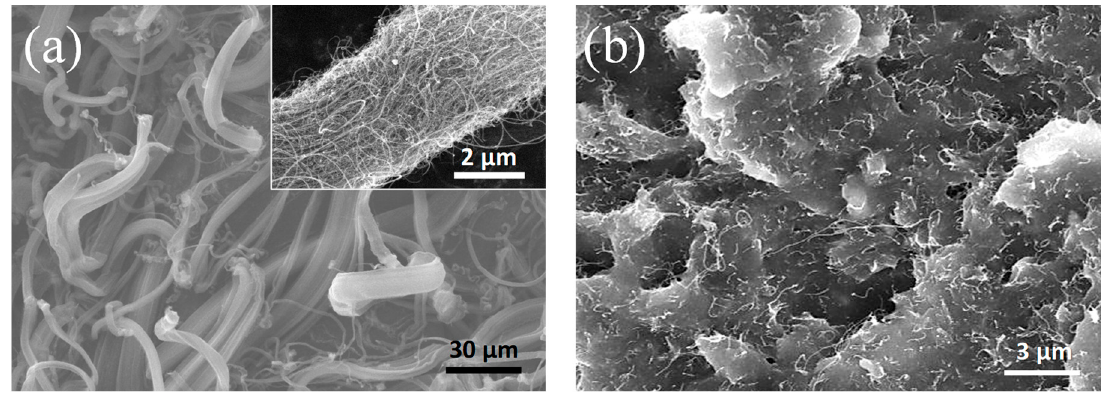
Figure 3. SEM micrographs of ( a ) as-received MWNTs, and ( b ) MWNT/polydimethylsiloxane (PDMS) composite.